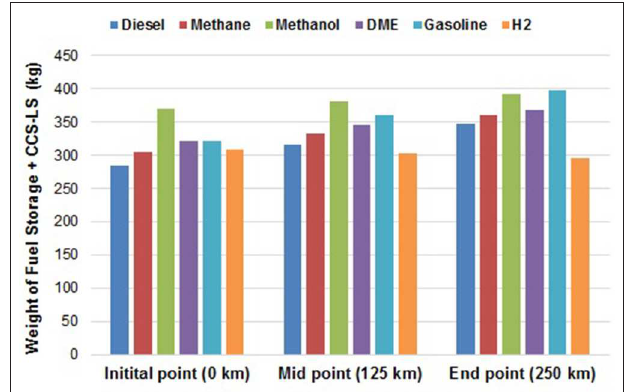
FIGURE 11 | Percentage added weight of CO 2 capture system and liquid storage (CCS-LS) with respect to total weight (A) and payload (B) of different